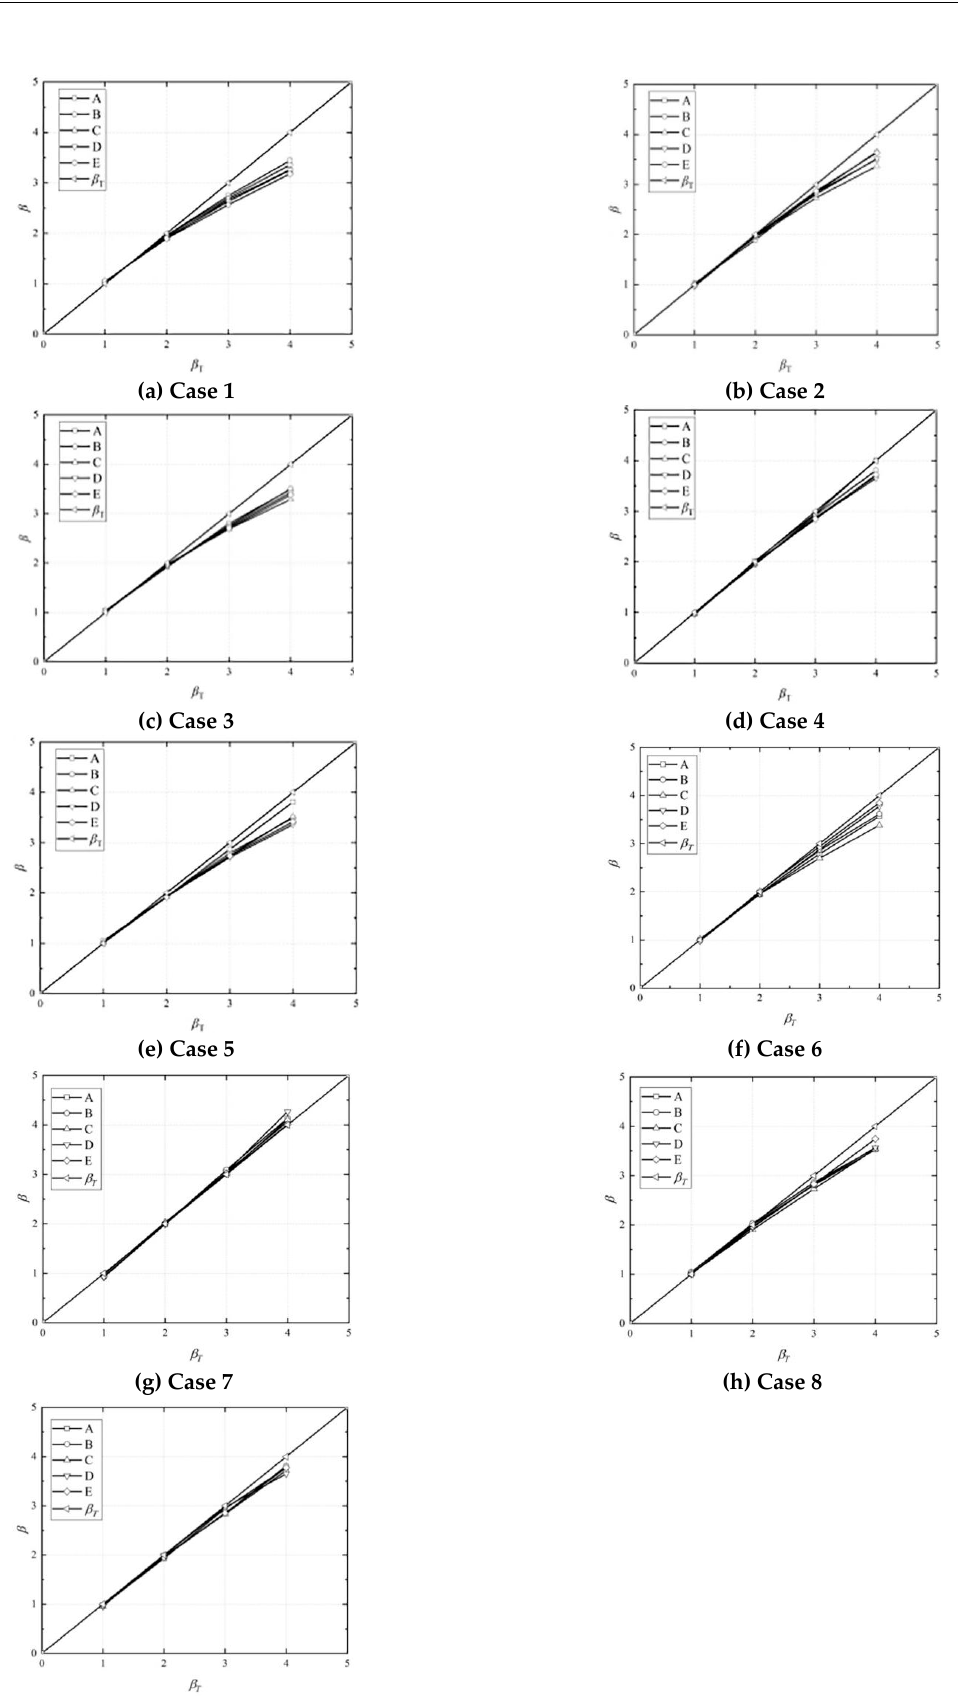
β ) computed using the proposed method. Figure 7. Reliability index (